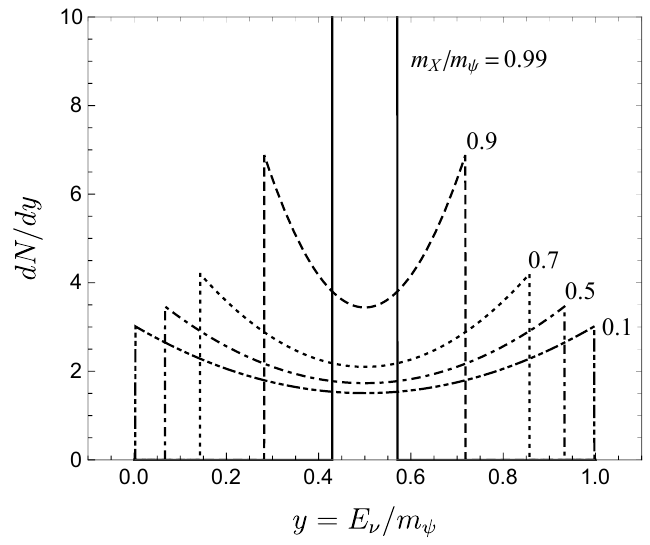
Figure 3 . The shape of the neutrino spectrum for the (cid:22) ! XX ! 2 (cid:23) 2(cid:22) (cid:23)